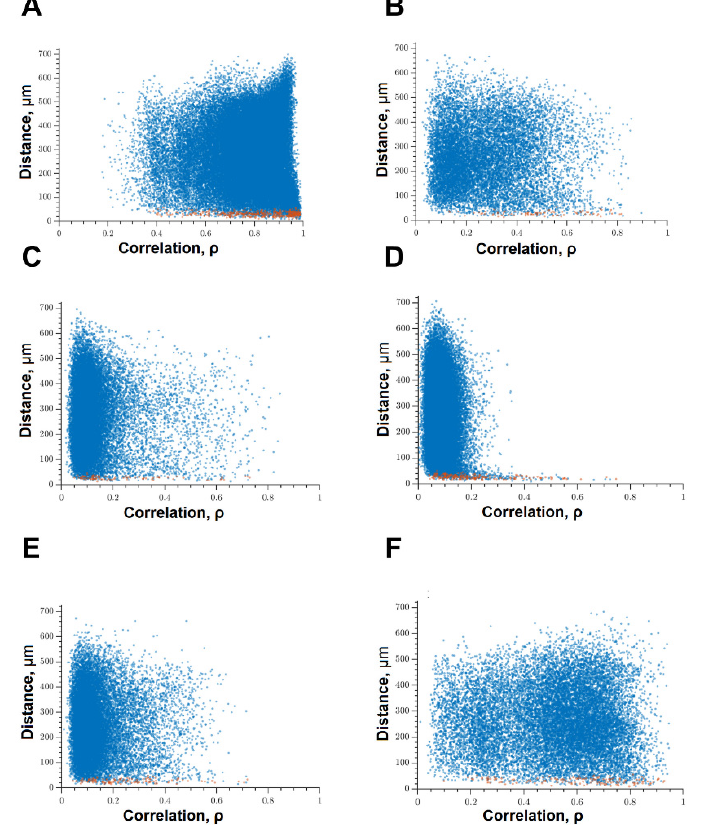
Figure 6. Correlation dependence between spontaneous Ca 2+ oscillations and cell distance (red dots—pairs of neighboring cells, blue dots—pairs of distant cells): ( A ) Sham; ( B ) glucose deprivation, ( C ) GD + SRC, ( D ) GD + Ikkb, ( E ) GD + eEF2K, ( F ) GD + FLT4.